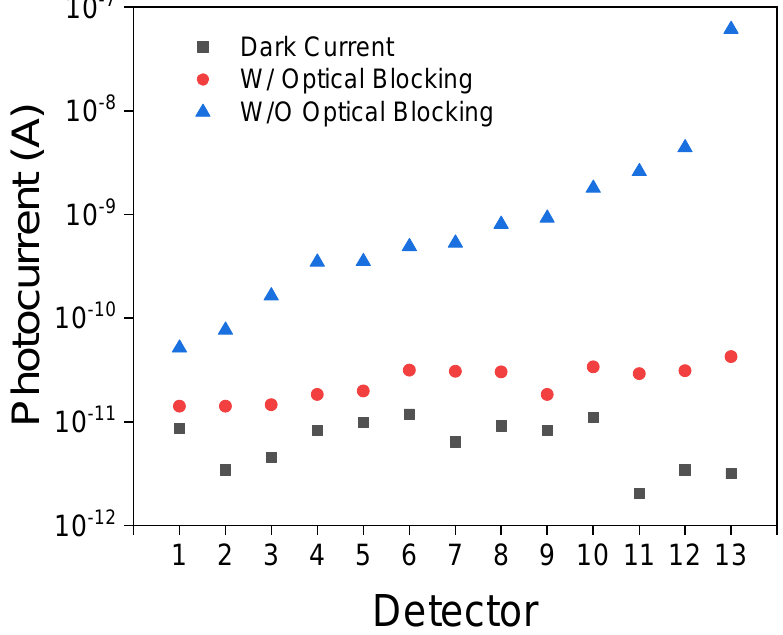
Figure 2. The photocurrents measured from the 13 photodetectors using a semiconductor parameter analyzer (Keithley 4200) under various scenarios: the dark currents measured when the on-chip LED was electrically disconnected; the photocurrents with and without the optical blocking structure integrated on the LED (shown in Figure 1a) which was biased at a constant 8V. LED emission reflected from an off-chip object is negligible. As a result, the photocurrents measured were the result of LED emissions being directly captured by the photodetectors along a direct path on the chip. With optical blocking, the photocurrent due to the LED interference can be considerably suppressed to be within the same order of magnitude as the dark current.